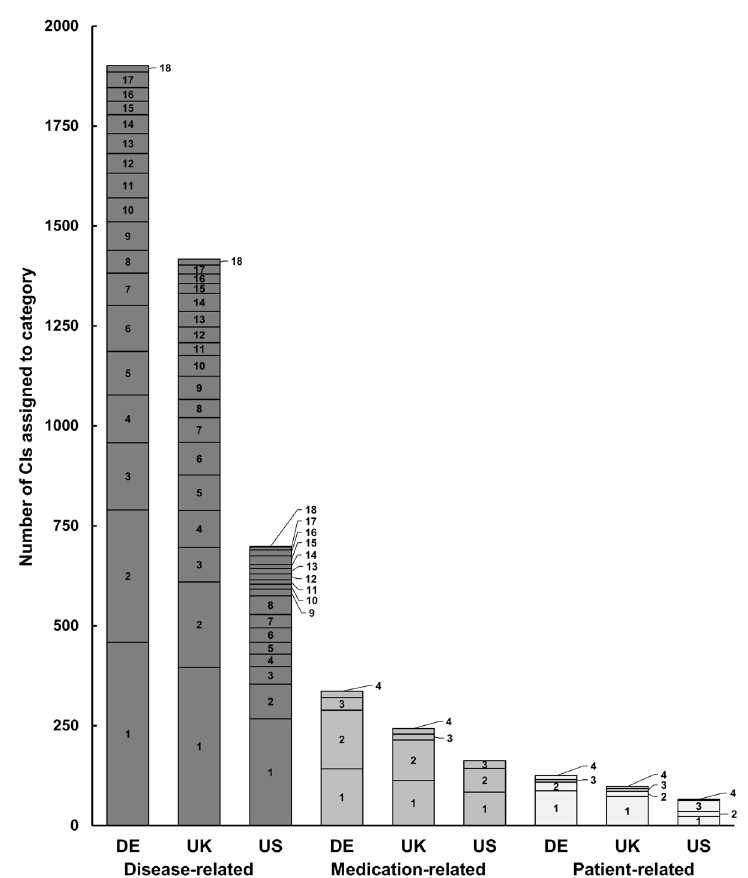
Figure 3. Number of individual absolute CIs assigned to each category, separately shown for German and UK SmPCs and US PI. Dark grey: disease-related CIs: 1: immune system, 2: cardiovascular system, 3: blood/blood formation, 4: liver, 5: gastrointestinal tract, 6: laboratory discrepancies, 7: metabolism, 8: respiratory system, 9: nervous system, 10: kidney, 11: neoplasia, 12: skin, 13: psyche, 14: infections, 15: urogenital system, 16: eyes/nose/throat/ears, 17: genetic disorders, 18: musculoskeletal system; medium grey: medication-related CIs: 1: drug, 2: drug-family, 3: administration, 4: dose; light grey: patient-related CIs: 1: pregnancy/birth/lactation, 2: age, 3: female sex, 4: other. CI: contraindication, DE: Germany, PI: Prescribing Information, SmPC: Summary of Product Characteristics.